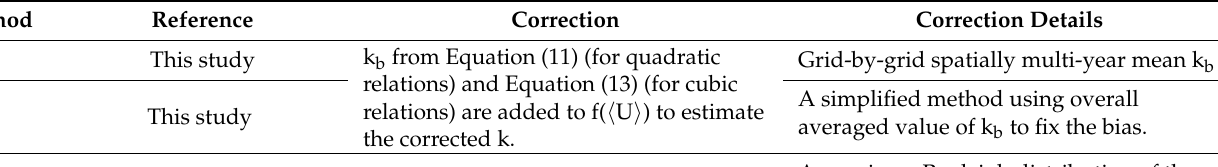
Table 2. Summary of all the correction methodologies for CO 2 and other gases.